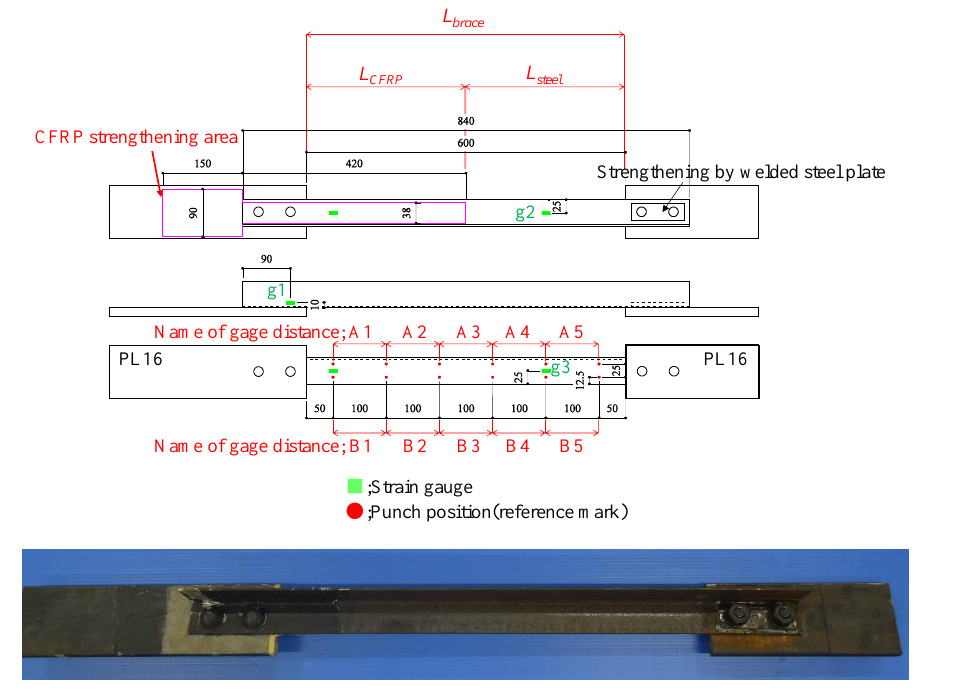
Figure 6. Geometry of specimen. Table 1. Evaluated load-carrying capacity